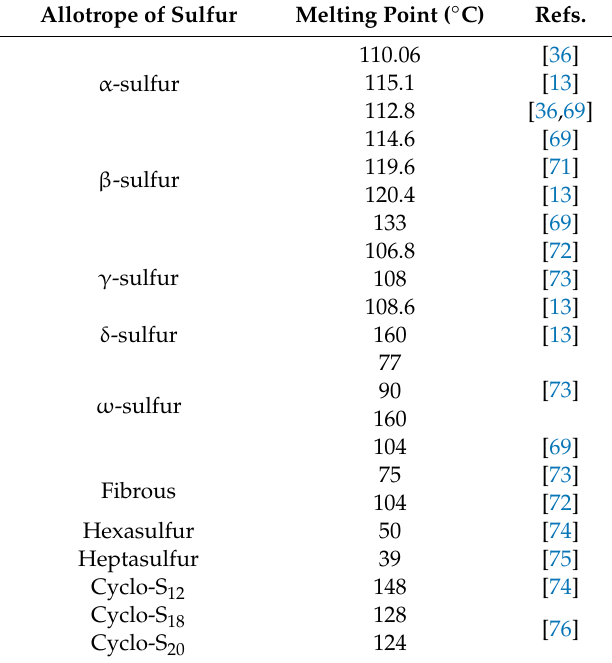
Table 2. Melting point of various allotropes of